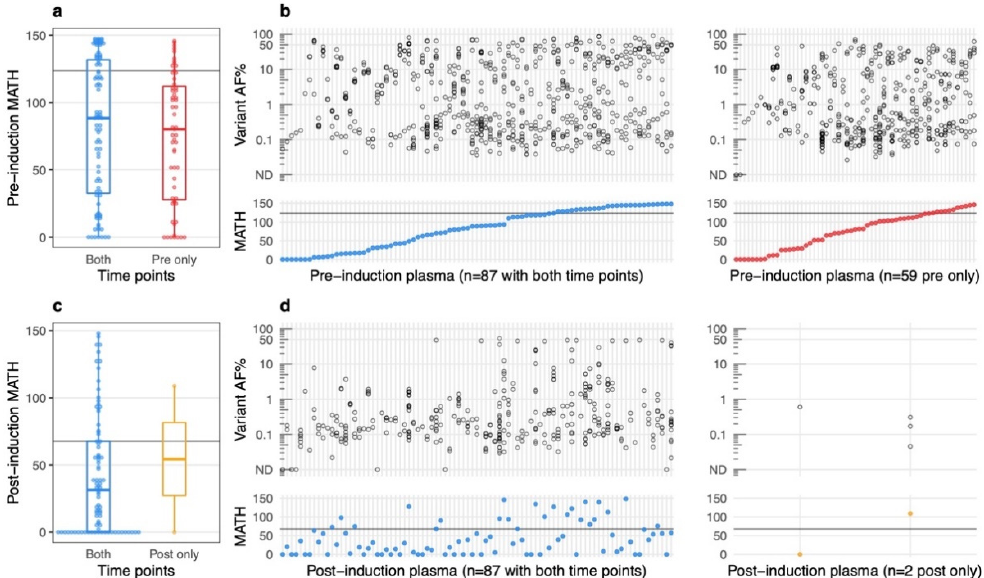
Figure 1. Distribution of plasma-based MATH scores. ( a ) Dot plot and boxplot of MATH measure- ments for pre-induction plasma samples. Each dot represents a sample. Pre-induction MATH values are not significantly different ( p -value = 0.2283, Wilcoxon rank-sum test) between patients with only the pre-induction time point (red) and patients with both pre-induction and post-induction time points (blue); ( b ) allele frequency (AF) of detected somatic variants for each sample (top panel). Each open circle represents a somatic variant. The sample’s corresponding MATH score is in the bottom panel. Samples have been ranked in order of increasing MATH score; ( c , d ) similar plots shown for post-induction plasma samples. The order of post-induction plasma samples in d matches that of the pre-induction plasma in b for the 87 patients with both time points available for analysis. For all plots, a horizontal line marking the top quartile in pre-induction and post-induction MATH scores is included.